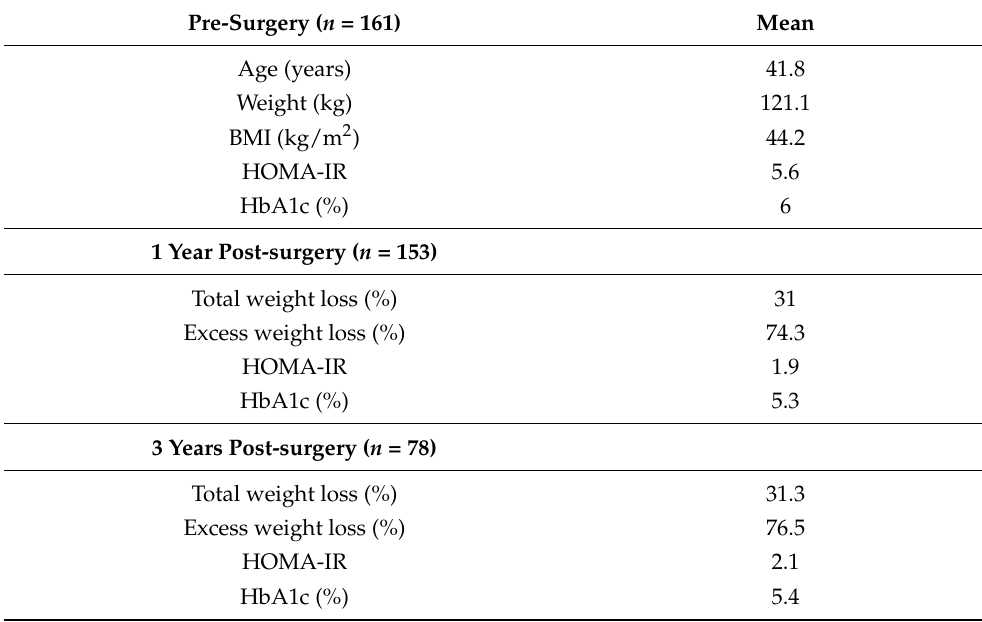
Table 1. Pre- and post-surgery characteristics of the